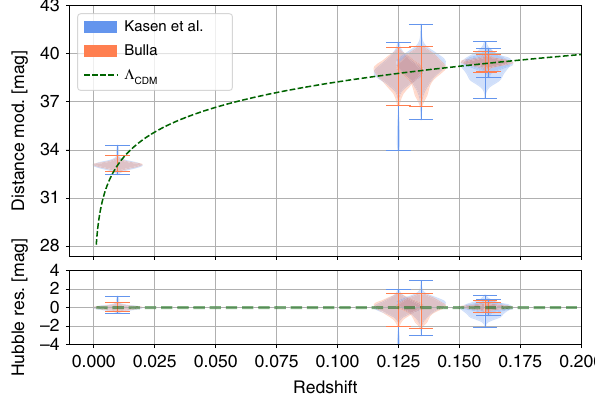
Fig. 3 Hubble – Lemai^tre Diagram for the kilonova analysis. We plot distance modulus vs. redshift. The error bars indicate the extent of the posterior samples. The green dashed line shows Λ CDM . We include a Hubble – Lemai^tre residual panel to show the